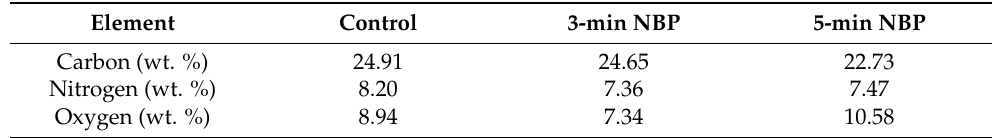
Figure 3. Scanning electron microscopy (SEM) morphology of the 3D chitosan scaffold after Non- thermal, biocompatible plasma (NBP) treatment. The chitosan scaffolds were treated with DBD or soft plasma jet NBP for 3 min and 5 min. Non-treated chitosan was used as control. ( a – f ) SEM images showing the morphology of control and DBD-based NBP-treated chitosan scaffold. ( g – o ) SEM images showing the morphology of control and soft plasma jet-based NBP-treated chitosan scaffold. Table 1. Chitosan carbon, nitrogen, and oxygen levels before and after 3- and 5-min Non-thermal, biocompatible plasma (NBP)